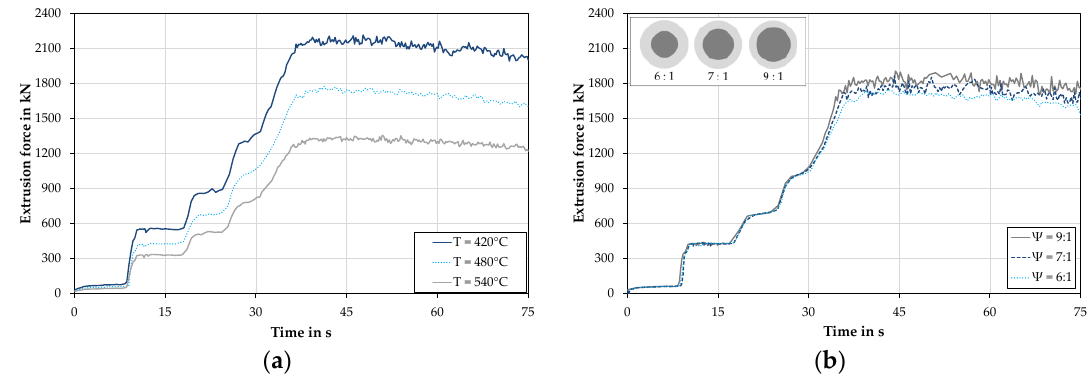
Figure 12. ( a ) Numerically predicted force-time curves for an extrusion ratio of 6:1 for different billet temperatures at a ram speed of 2 mm·s −1 ; ( b ) For different extrusion ratios at a billet temperature of 480 °C and a ram speed of 2 mm·s −1 .